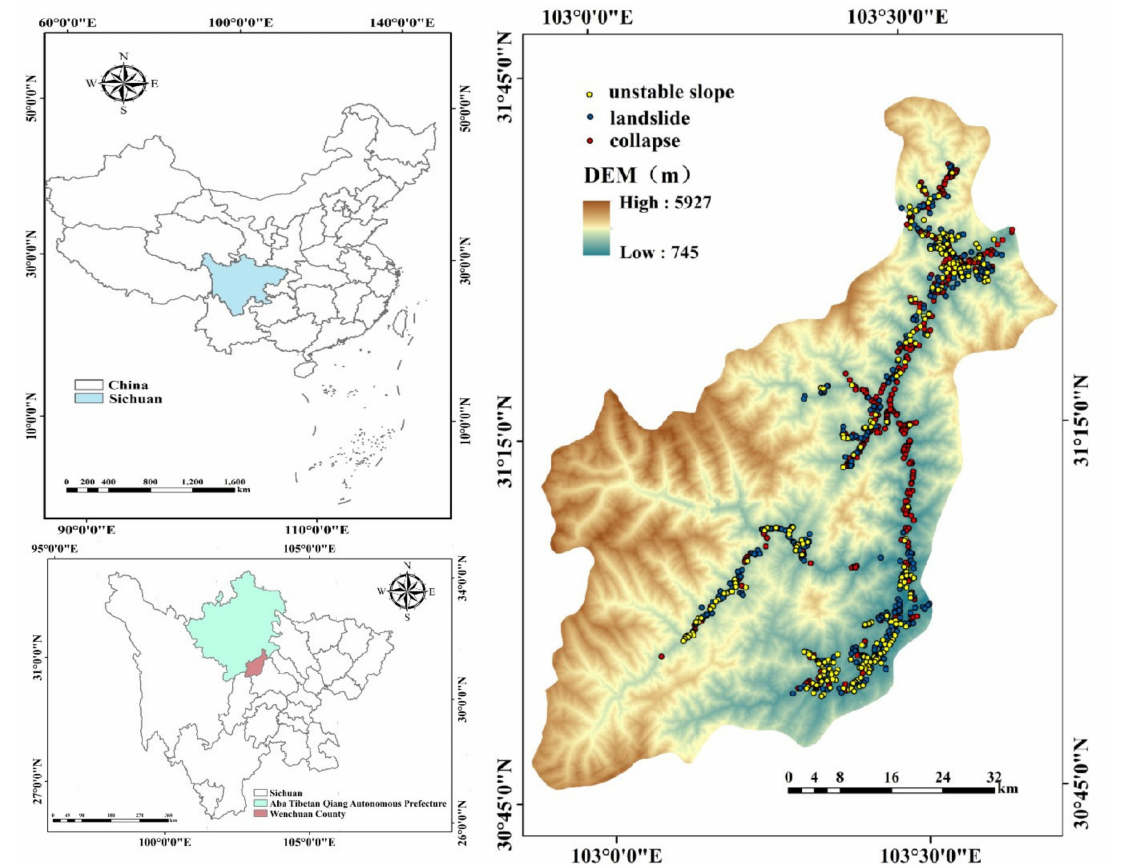
Figure 1. Geographical location of the research area and distribution of historical collapses and